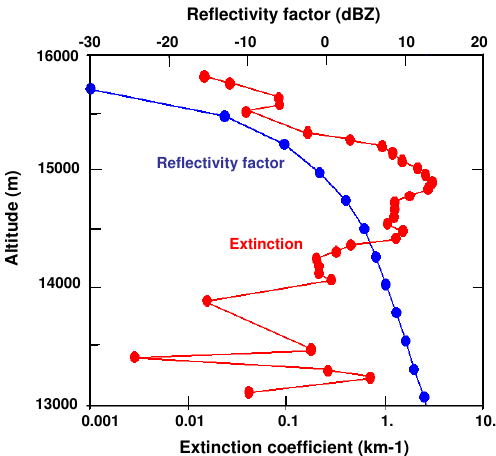
Fig. 5. Same as Fig. 2, but for profiles obtained at the centre of part B of the convective cell (1.840 ◦ N, see Fig. 4) for the 20 June 2008 MCS.